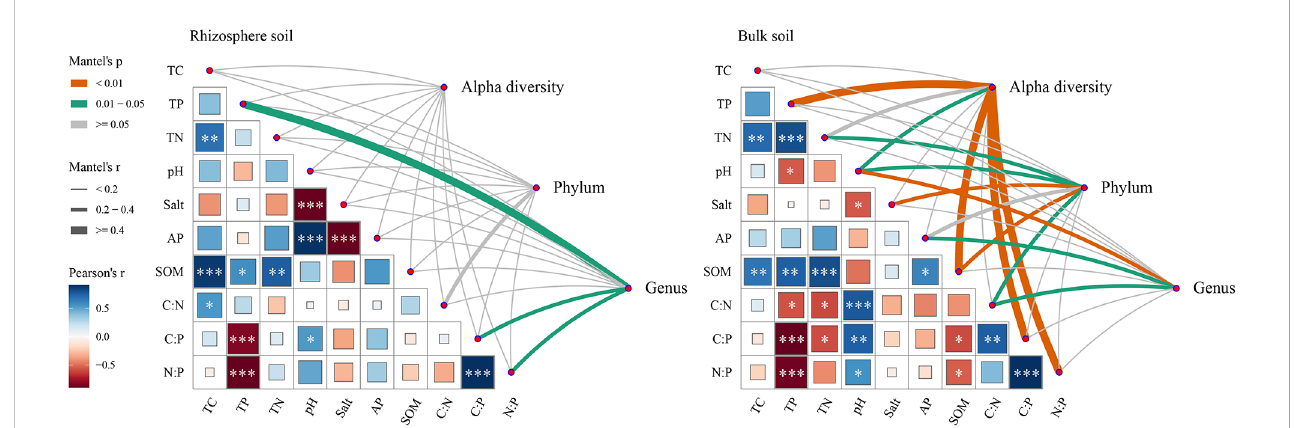
FIGURE 6 The mantel test between bacterial community and environmental factors in rhizosphere and bulk soil of S. salsa in different N-P addition ratio treatments. Note: Alpha diversity represents the alpha diversity index (Chao1, Shannon, Simpson, Faith_pd and Observer OTUs index) of the bacterial community. Phylum represents the dominant bacterial phyla of the bacterial community. Genus represents the dominant bacterial genus of the bacterial community. *, **, *** indicate that the correlation between the environmental factor is signi fi cant at 0.05, 0.01 and 0.001 level,